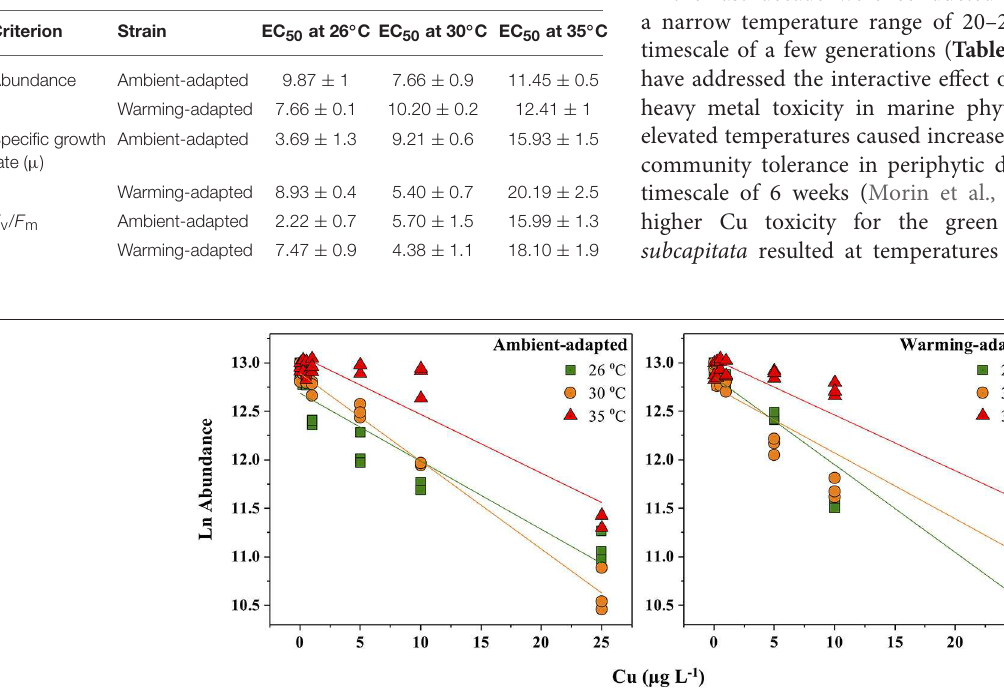
FIGURE 1 | Response of Ln cell abundance of ambient-adapted and warming-adapted Chaetoceros tenuissimus to Cu exposure at ambient (26 ◦ C; green), warming (30 ◦ C; orange), and extreme warming (35 ◦ C; red) temperatures. Each individual shapes denotes individual replicates and the lines indicate linear regression.